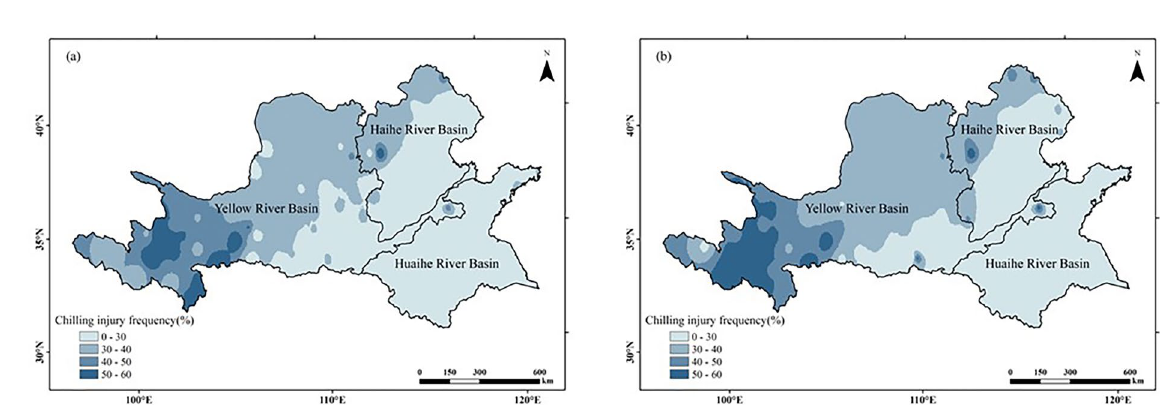
Figure 11. Waterlogging frequency of peanut growing season in the Huang-Huai-Hai region in two climatic years: ( a ) 1960–1989; ( b ) 1990–2019. The figure was made in the ArcGIS 10.2 platform (https:// www. esri. com/ en- us/ home).